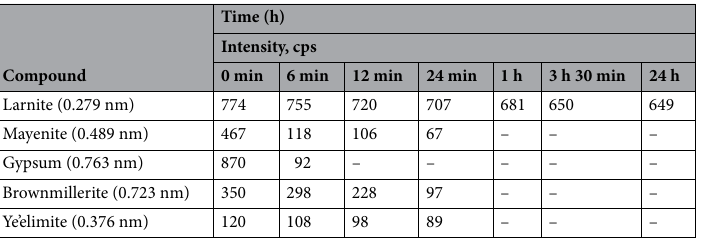
Time (h) Intensity, cps 0 min 6 min 12 min 24 min 1 h